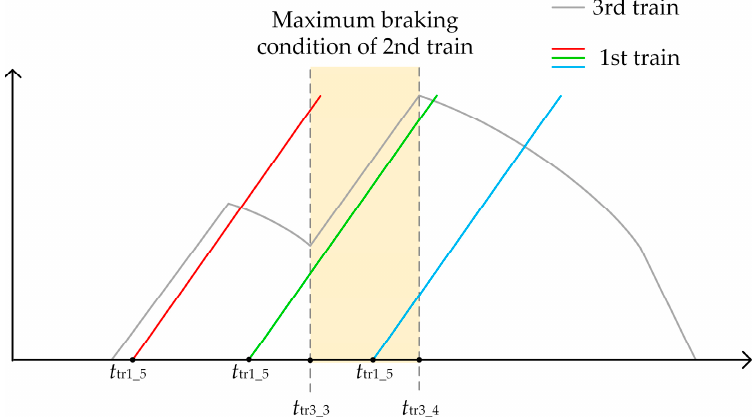
Figure 8. The traction curves of the 1st train when the 3rd train operates in five-mode operation.